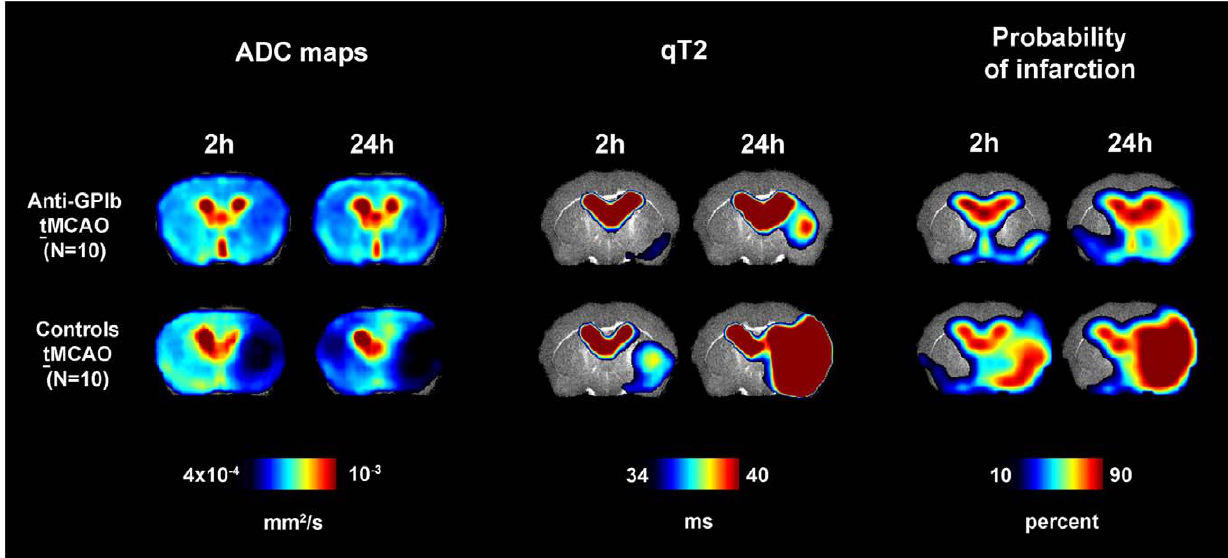
Figure 3. Maps of ADC (left), quantitative T2 (qT2, middle) and probability of infarction (right). Measures are given as group means per time point. The lower threshold of qT2 was chosen to be the segmentation threshold for infarction (34 ms). Strong protection from cerebral infarction was observed in anti-GPIb treated mice reflected by a substantially lower probability of completed infarction as evident on ADC, qT2 and probability maps (upper row, anti-GPIb ). This finding was most marked in the cortex of the MCA territory. In control mice after t MCAO, cerebral infarction involved the cortex in the center of the MCA territory and the complete deep MCA territory with high probability (lower row, controls t MCAO).